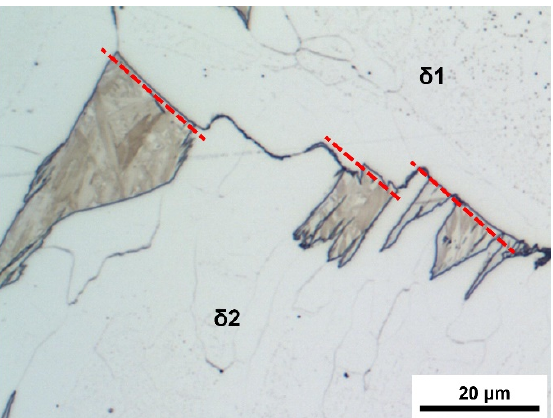
Figure 2. Rotation of a high-angle δ-ferrite grain boundary caused by nucleation of austenite exhibiting the OR with the δ 1 grain. WA laths growing into the δ 2 grain obeyed the OR with this grain. WA transformed to martensite. LM.